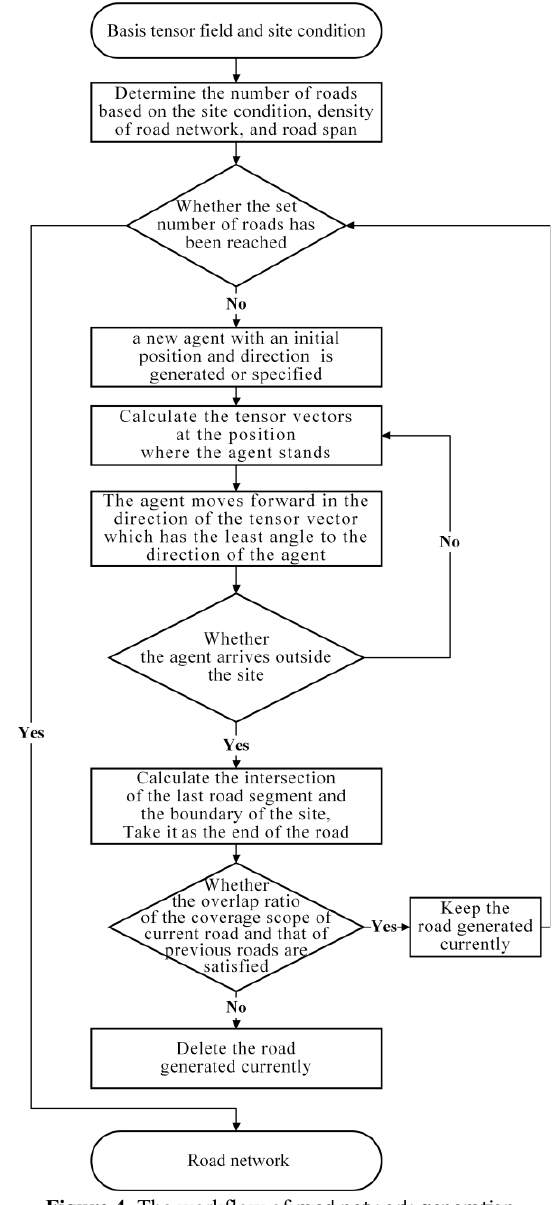
Figure 4. The workflow of road network